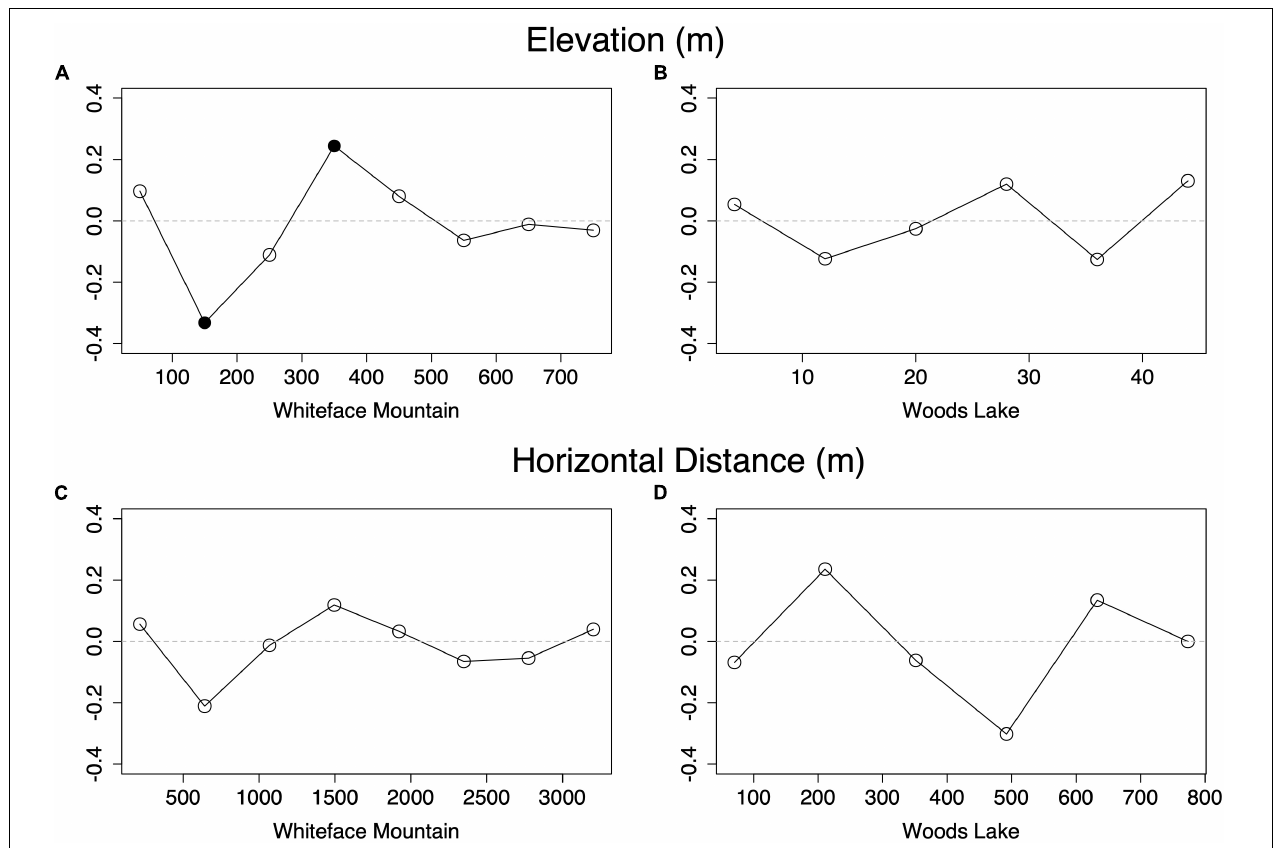
FIGURE 3 | Partial Mantel tests indicate that beta diversity varies significantly with respect to elevation at Whiteface Mountain (A) but not at Woods Lake (B) , and that beta diversity does not significantly correlate with horizontal distance at either site (C,D) . Filled points indicate significant correlation ( p <